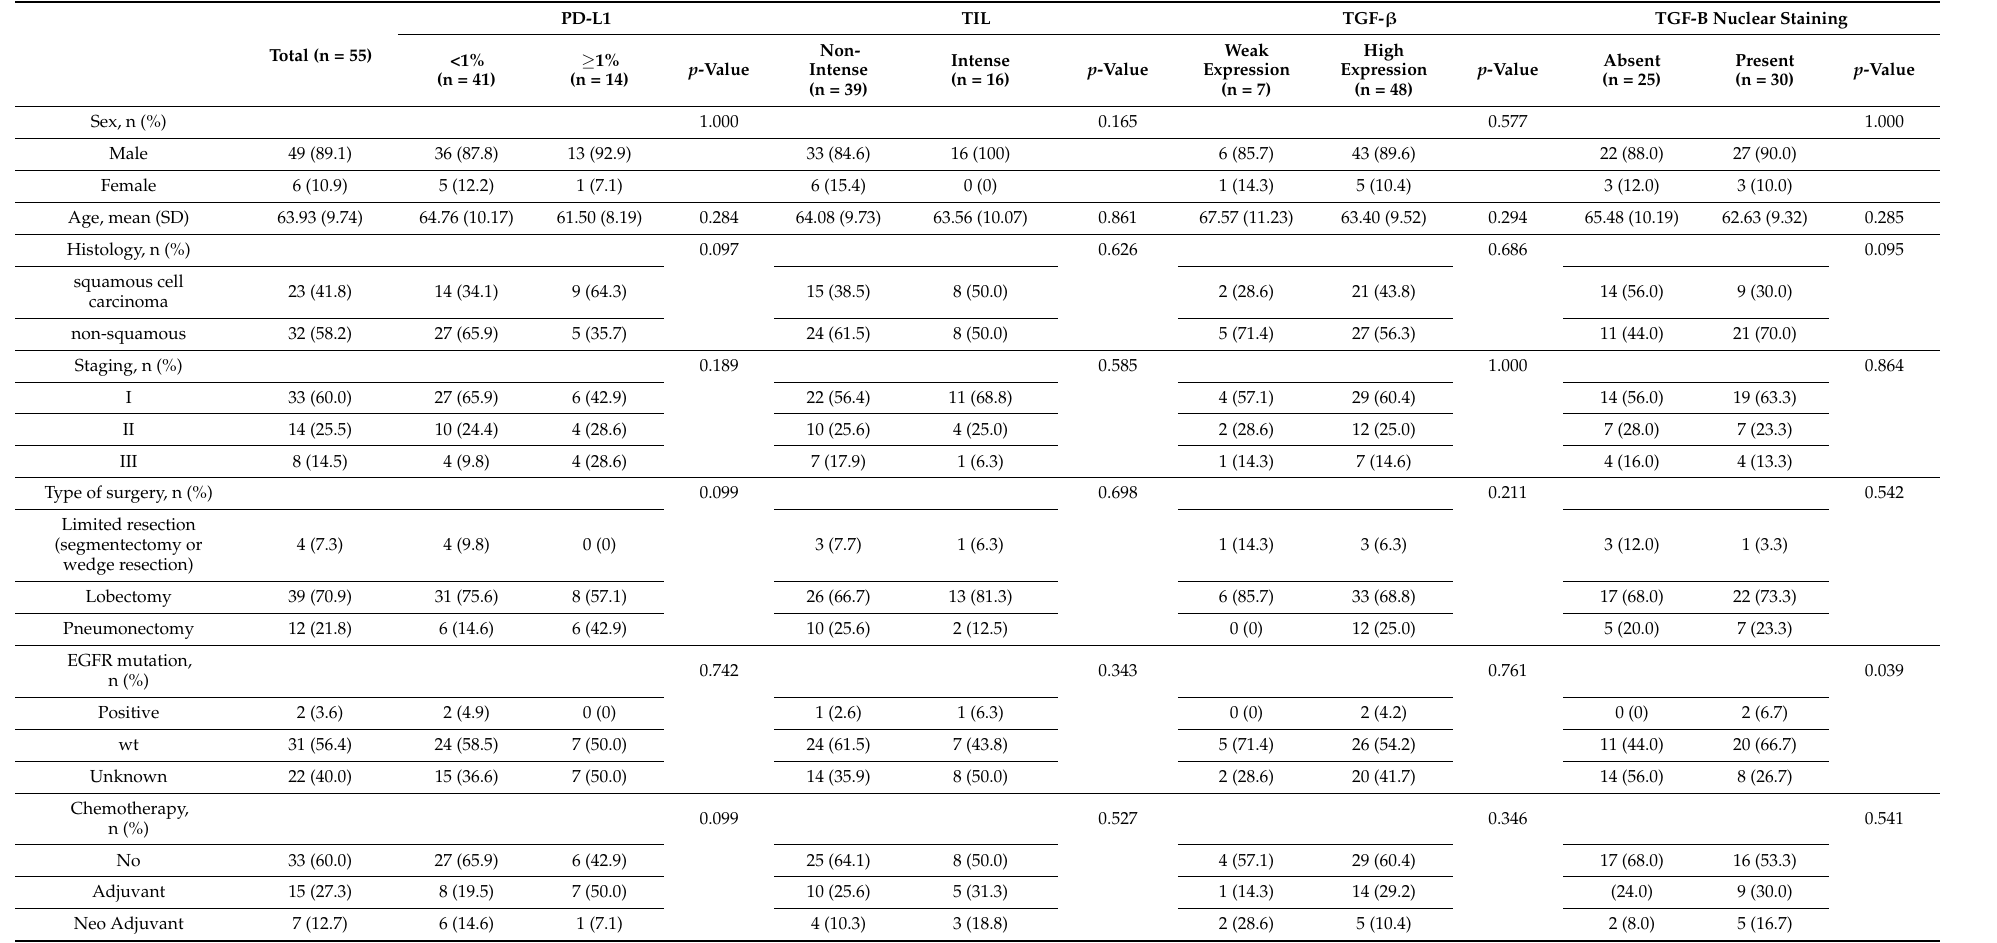
Table 1. Characteristics of the patients with available sample, and comparison of the distribution according to the study